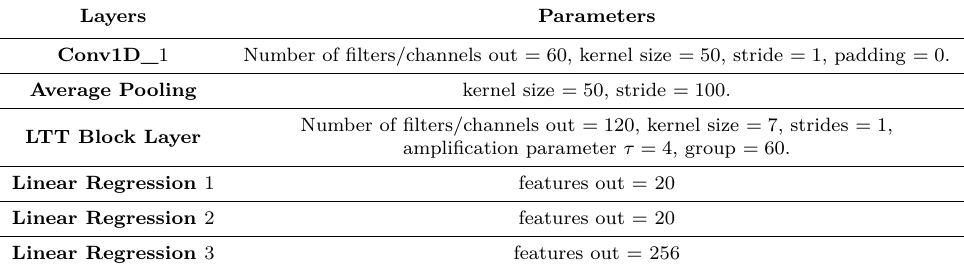
Table 3: Parameters of TT-DCNN used for ASCADv1_f dataset Layers Parameters